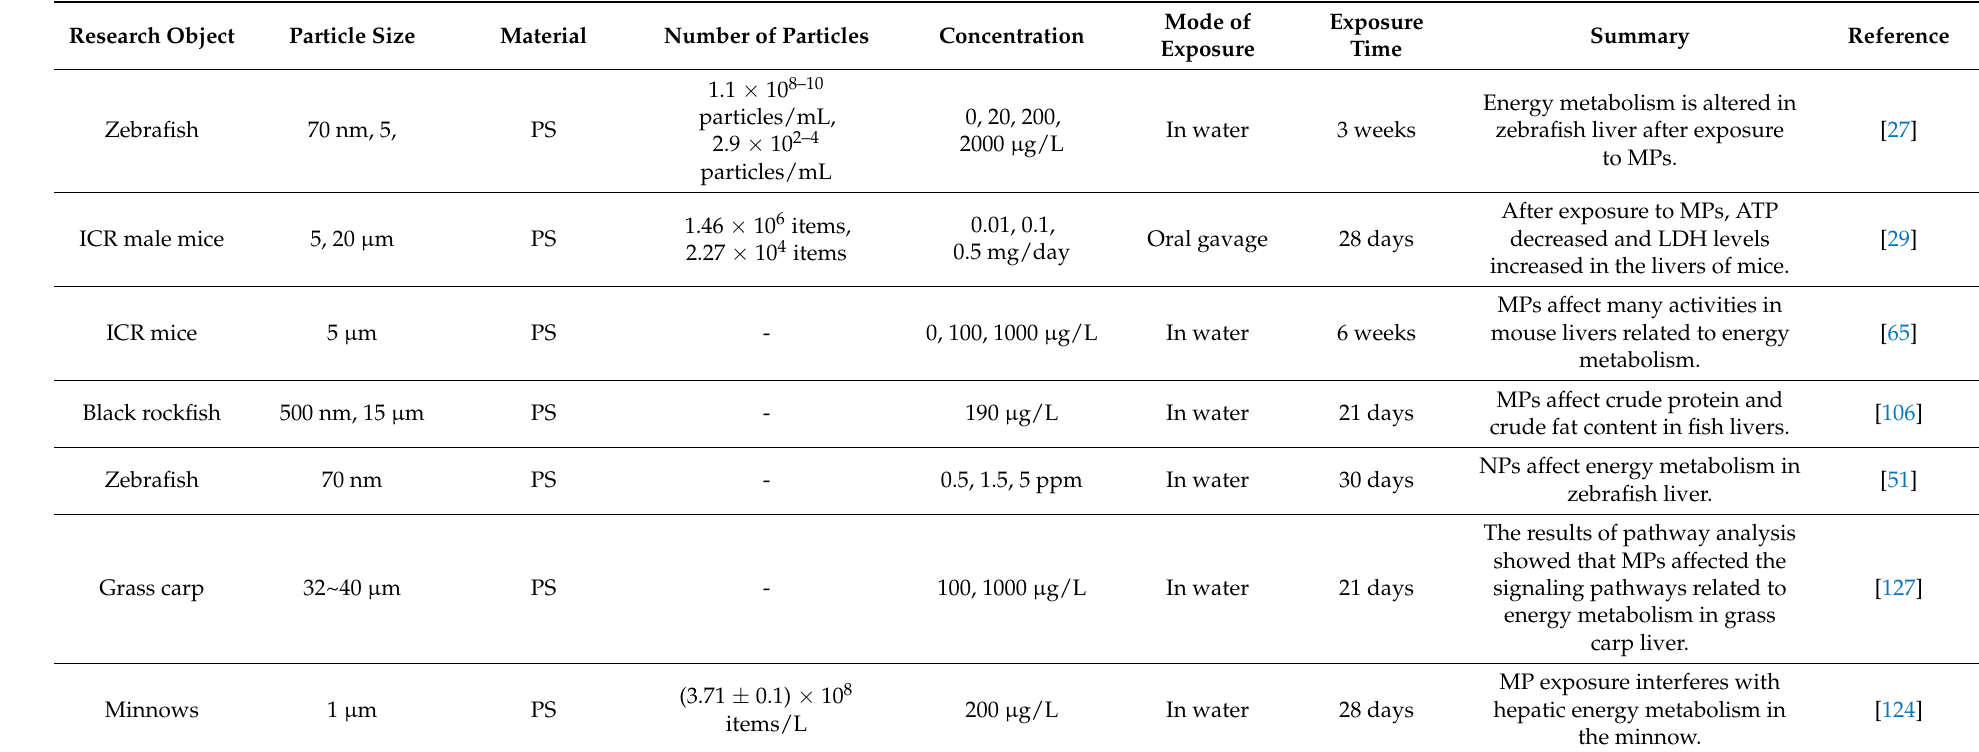
Table 7. The study parameters and effects of MPs and NPs on hepatic energy